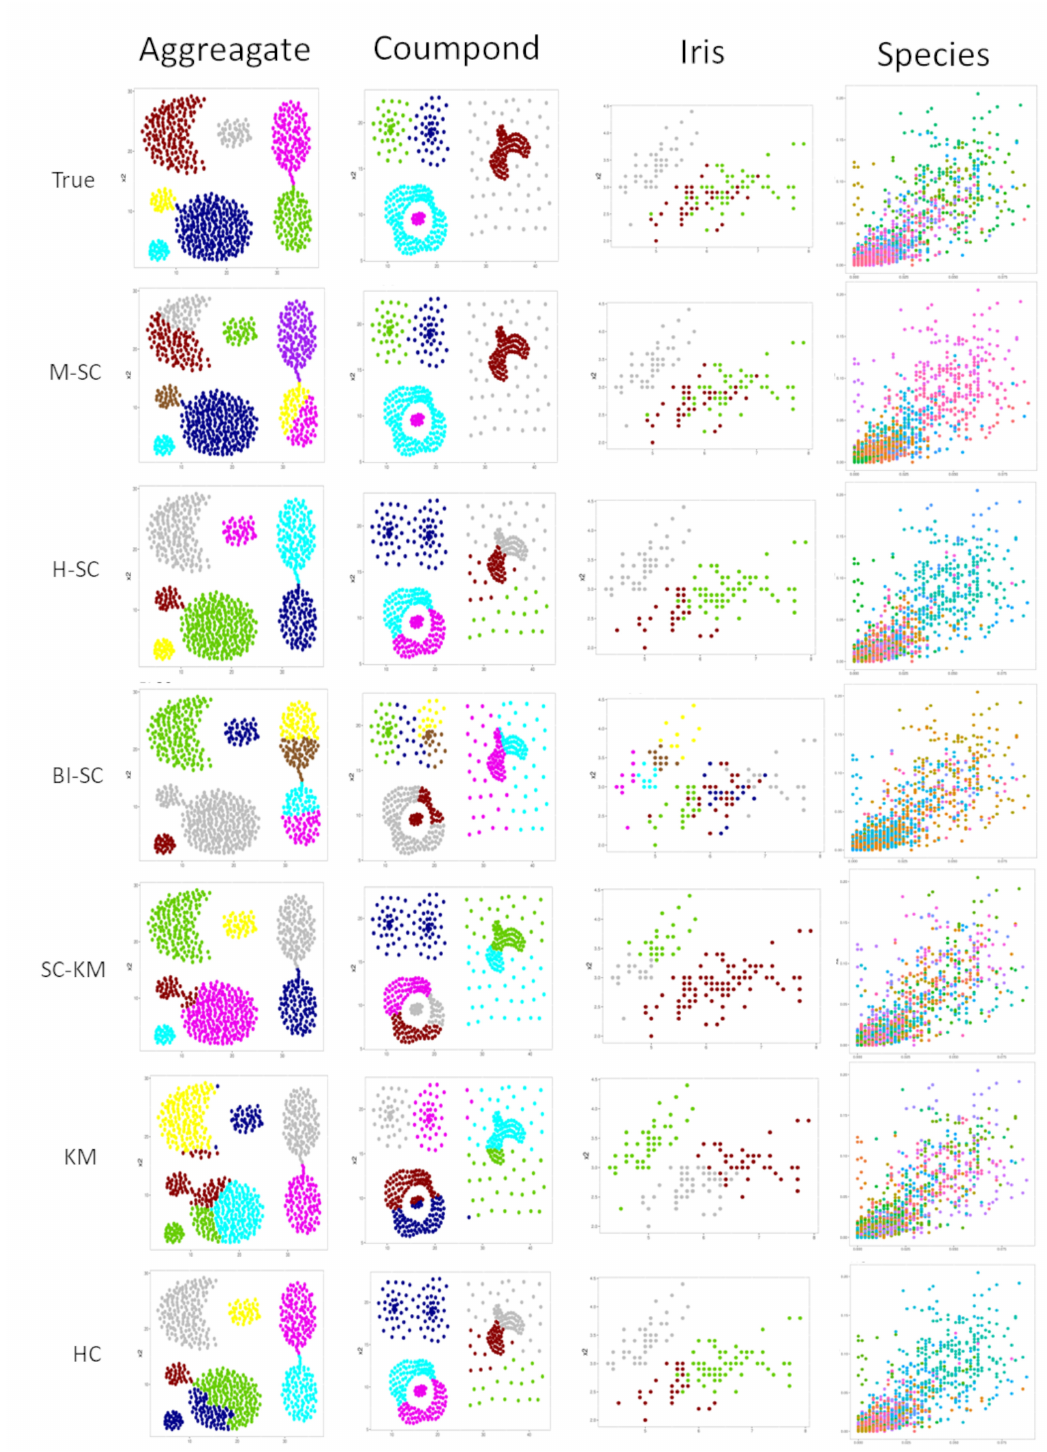
Figure 2. Color-labelling for the most efficient clustering methods on spatial dataset (True: ground-truth labels, M-SC Multi level Spectral Clustering, H-SC: Hierarchical clustering, Bi-SC; recursive bipartite SC, SC-KM: SC-Kmeans, KM: Kmeans, HC: Hierarchical